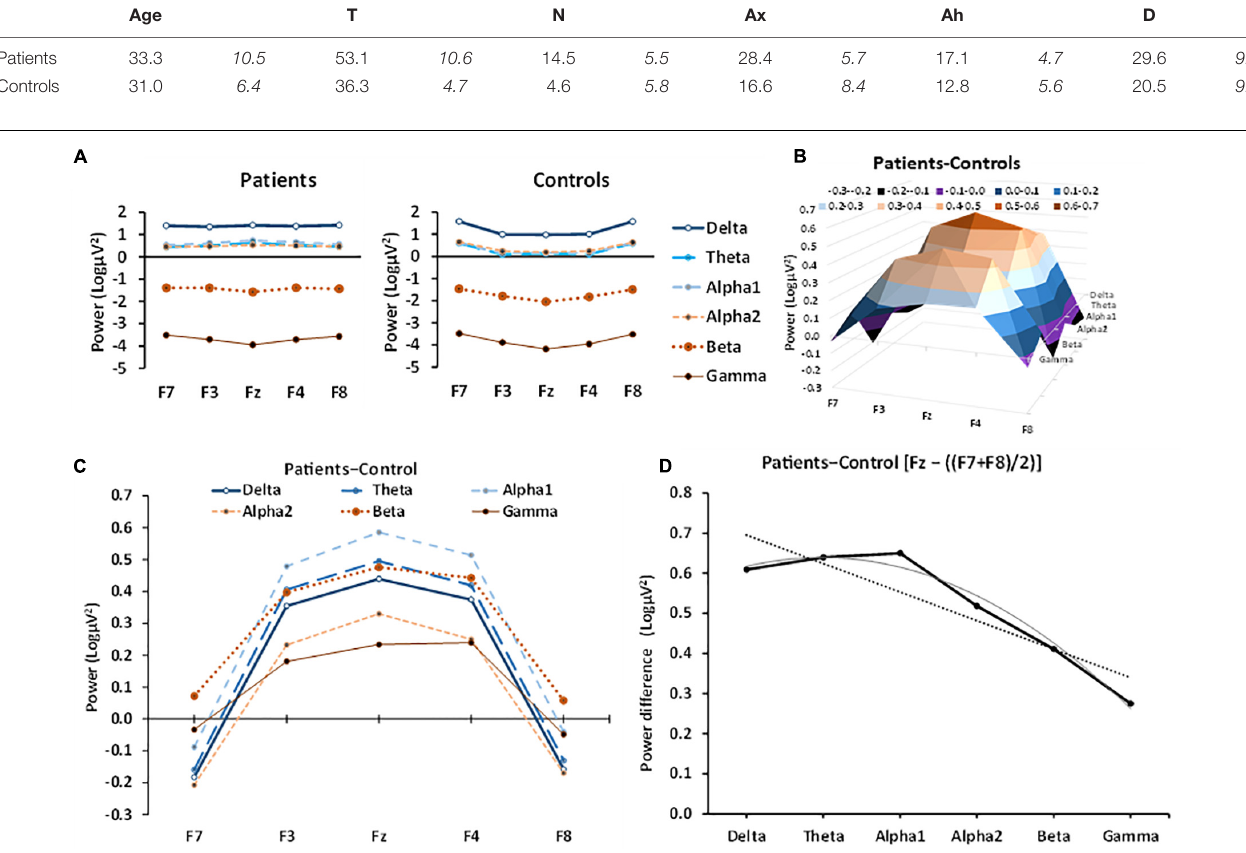
Frontiers in Neuroscience |